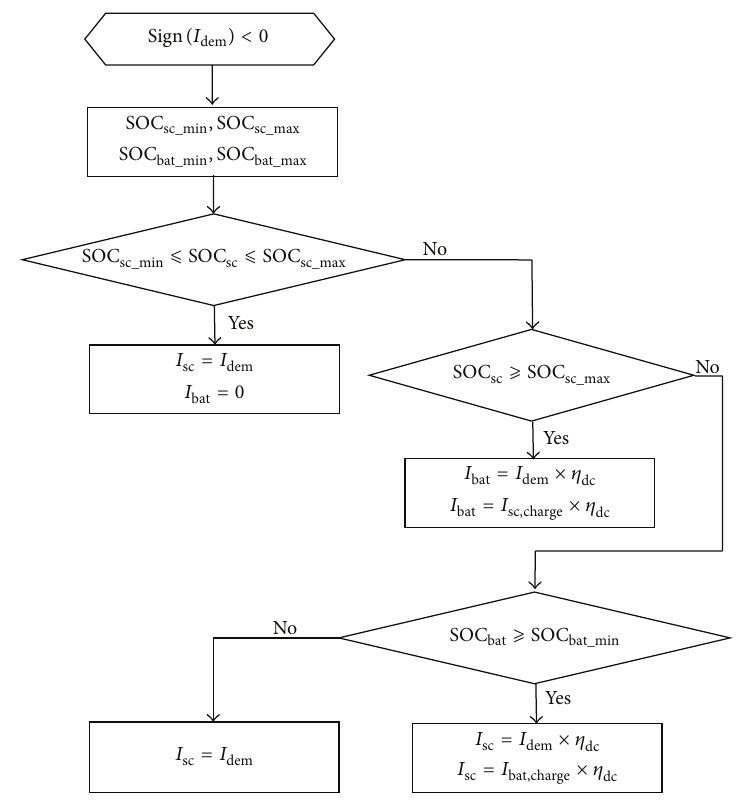
Figure 10: Flowchart of braking condition control mode.